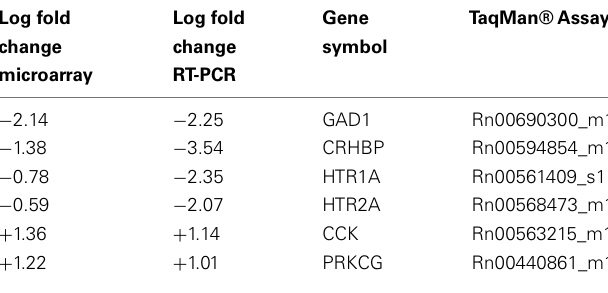
Table 2 | RT-PCR and Microarray results comparison ( p <